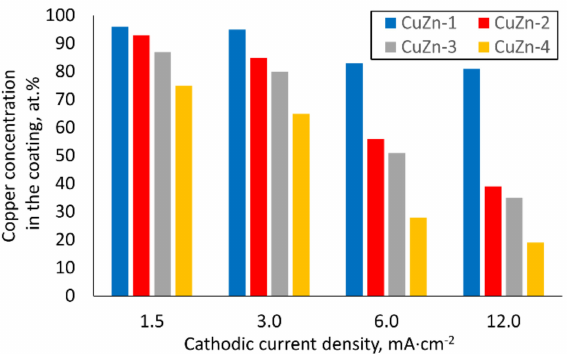
Figure 9. The bar chart showing chemical composition of the brass coatings (at. % of copper).